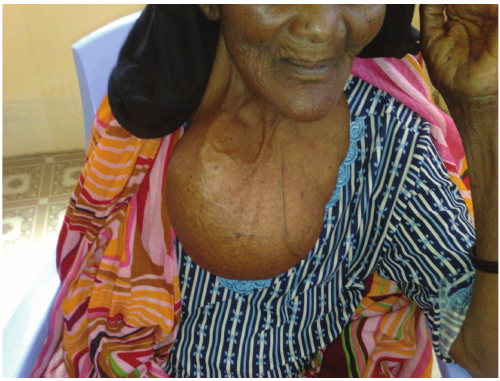
Figure 1: External view of the neck of the patient who underwent to surgery. Observe the large gland.